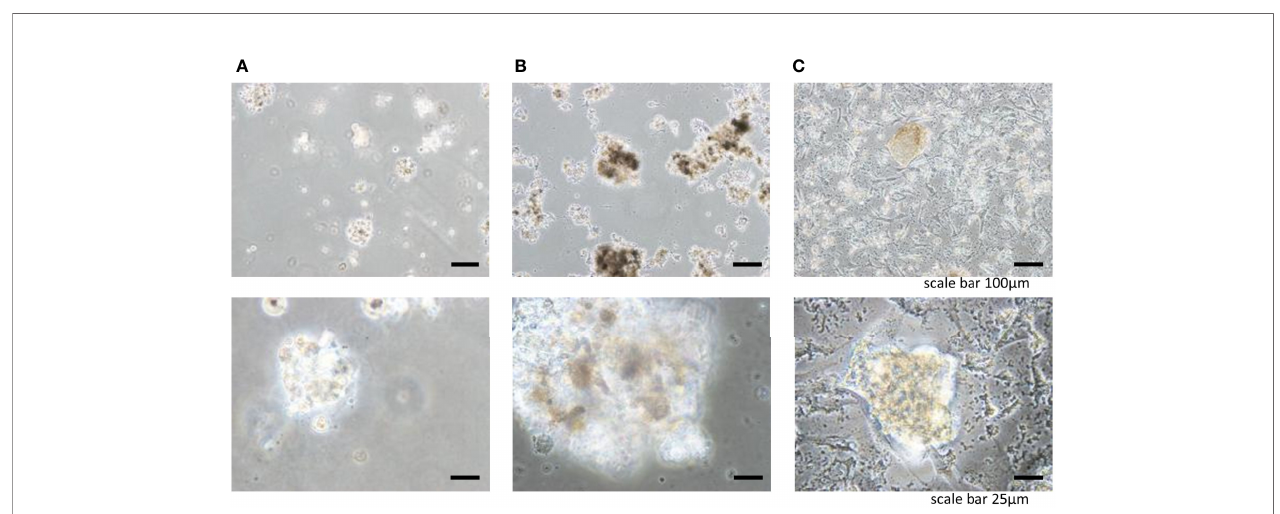
FIGURE 3 | Three-dimensional cell colonies BT549 in (A) Matrigel, (B) lung, (C) liver.